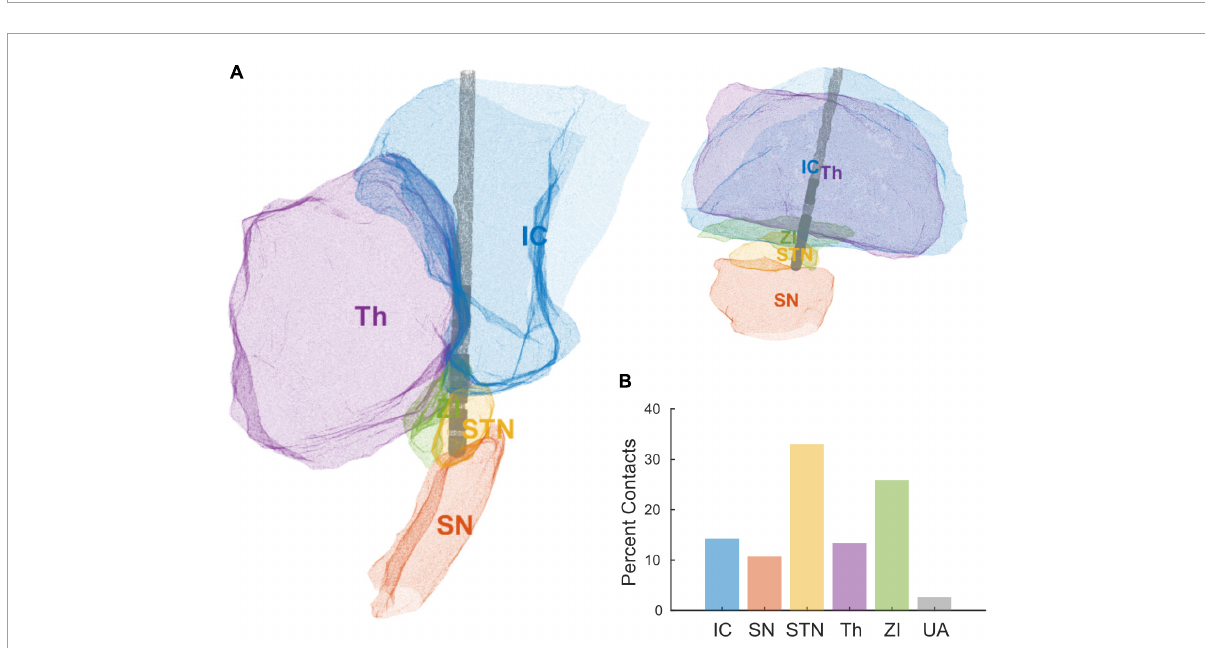
FIGURE2 (A) Reconstruction of a single patient’s DBS lead and local anatomical regions using STL files exported from Brainlab. (B) Percent of contacts’ anatomical assignments, across all the patients, using the area of most overlap with a given a contact. Areas include internal capsule